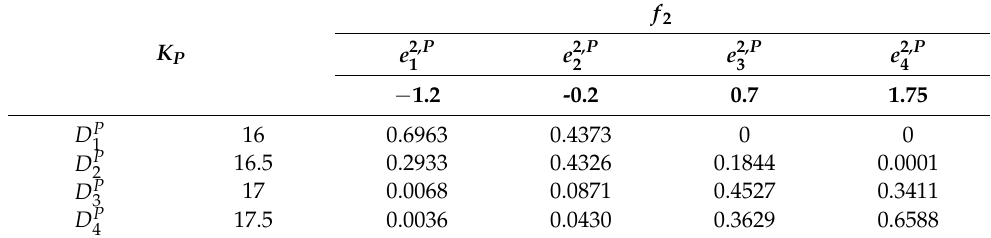
Table 9. IREM P of the input f 2